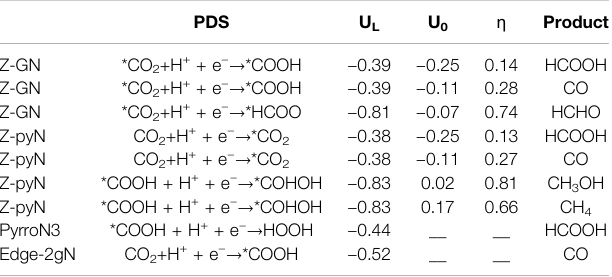
TABLE 2 | Potential determining steps (PDSs), limiting potentials (U L /V), and overpotentials ( ƞ /V) for CO 2 RR on Z-GN and Z-pyN. U 0 is the equilibrium potential. Comparison has been made with previous studies. U L , U 0 , and ƞ are all vs. the RHE.